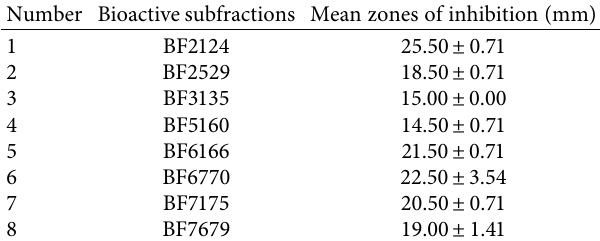
ND-not determined, n � 3. Table 7: Antimicrobial activity of DO5 bioactive subfractions against S. aureus